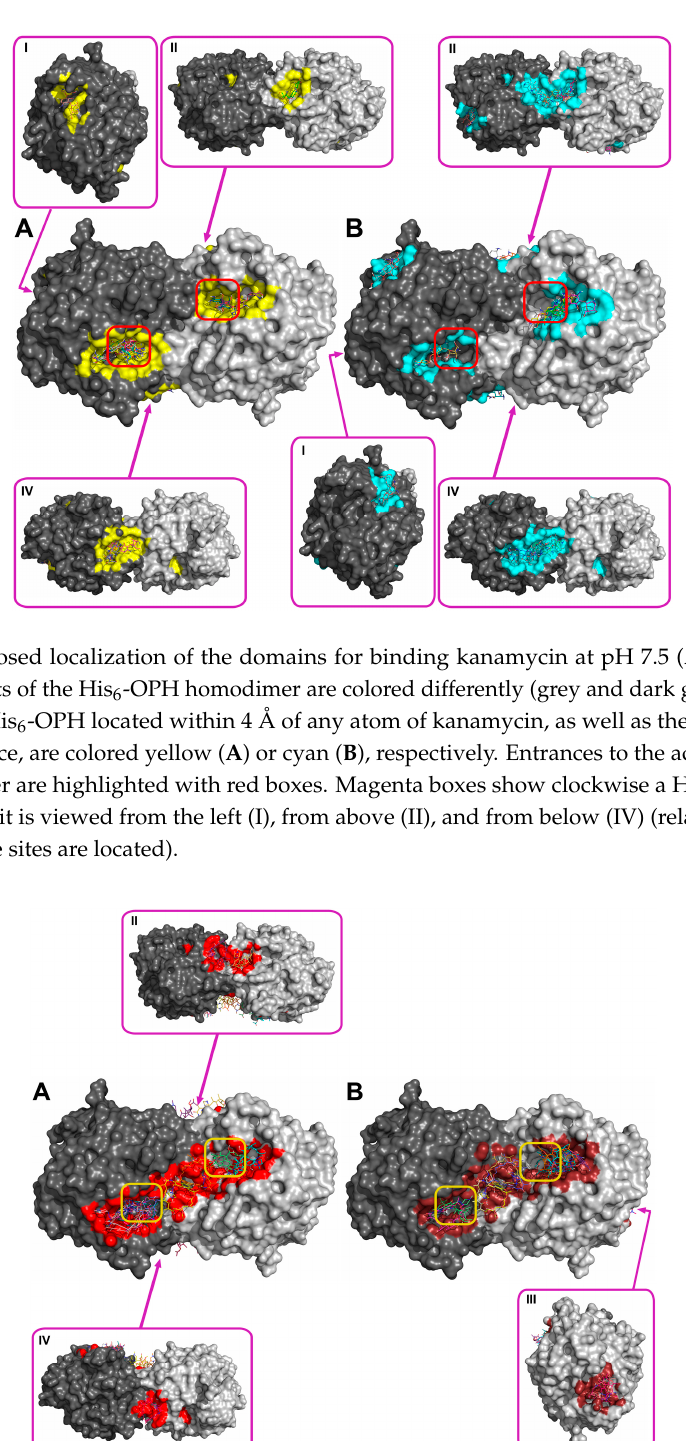
dimer are highlighted with yellow boxes. Magenta boxes show clockwise a His 6 ‐ OPH dimer molecule when it is viewed from above (II) and below (IV) (relative to the side where the active sites are located).